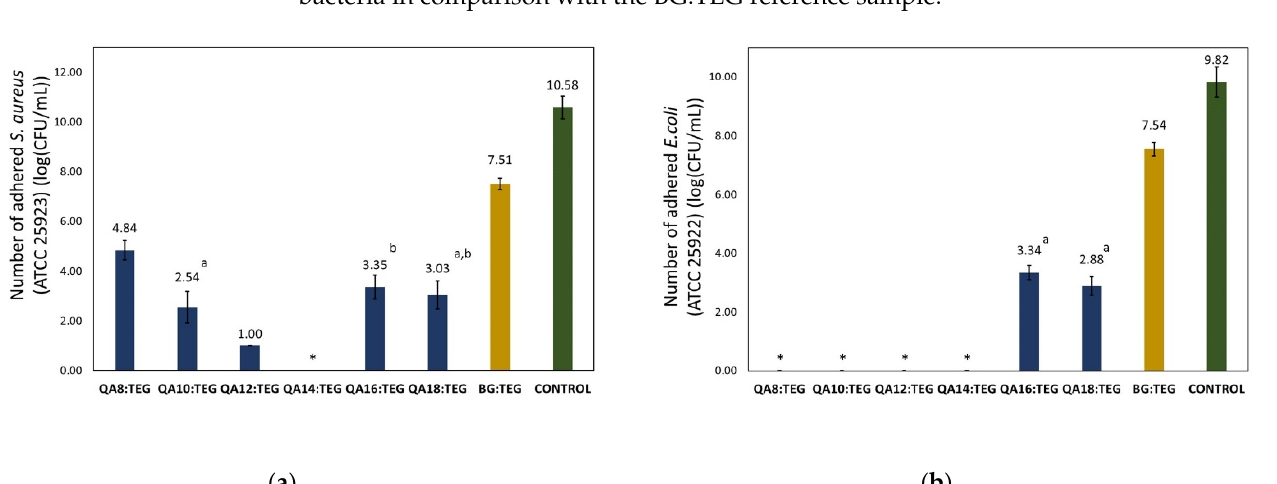
Figure 6. The results of the bacterial adhesion tests with ( a ) S. aureus (ATCC 25923) and ( b ) E. coli (ATCC 25922) on the studied copolymer surfaces after 18 h of incubation. An asterisk (*) indicates that no adhered bacteria were observed. Lower case letters indicate statistically insignificant differences ( p > 0.05) (non-parametric Wilcoxon test).